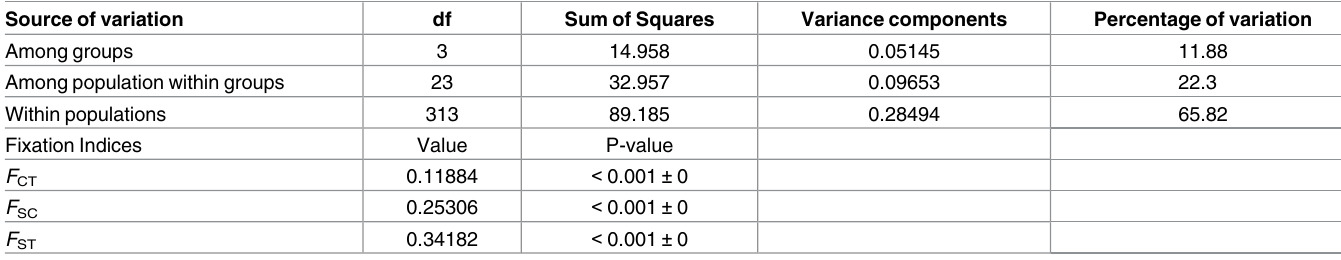
Table 6. Structure of populations within Clade E as determined by AMOVA. Source of